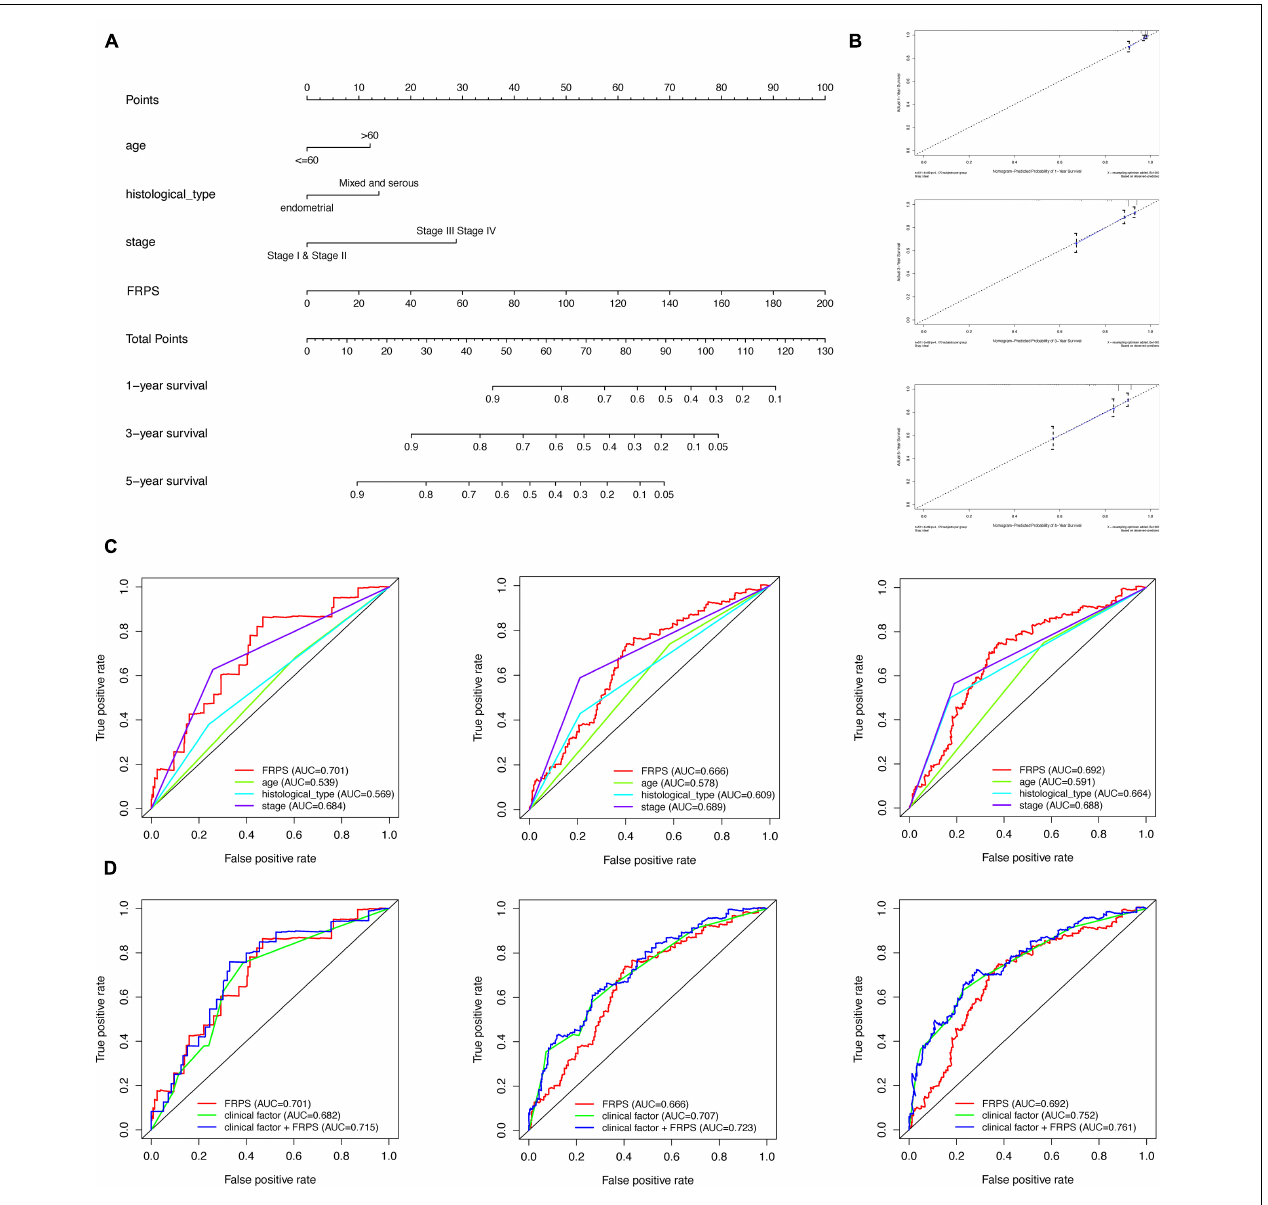
FIGURE 5 | Construction and validation of the nomogram. (A) Nomogram to predict the probability of 1-, 3-, and 5-year OS of UCEC patients. (B) Calibration curves of the nomogram to predict the probability of OS at 1, 3, and 5 years. (C) 1-, 3-, and 5-year ROC of FRPS and the other clinical characteristics. (D) 1-, 3-, and 5-year ROC of the combination of FRPS and clinical